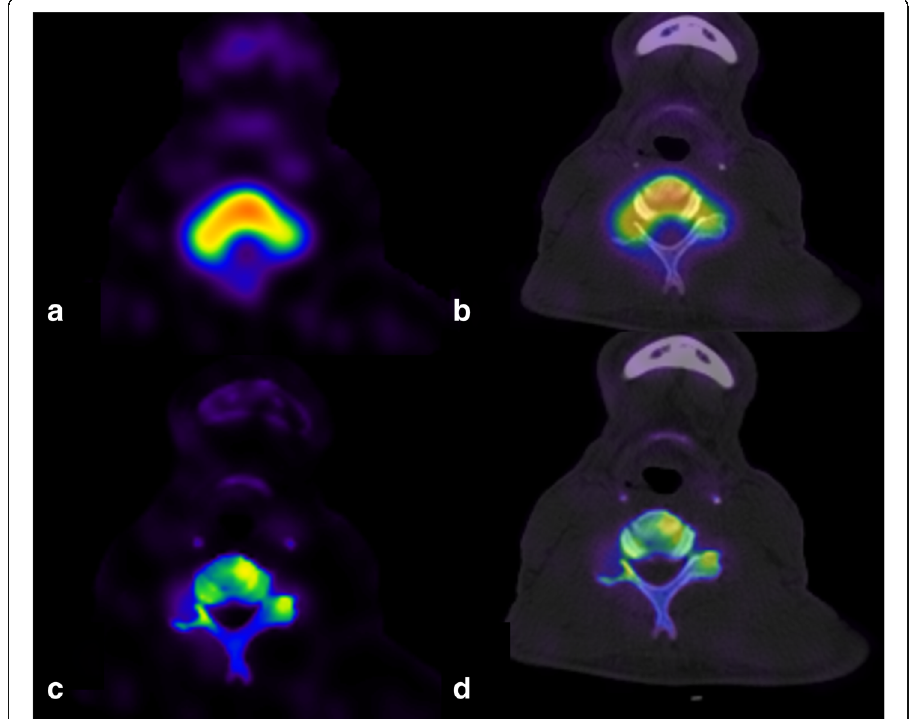
Fig. 4 Patient presented with neck pain for evaluation. Detailed Legend: Subsequent xSPECT and SPECT fusion at the C6 level are shown. a SPECT, b SPECT/CT, c xSPECT, and d xSPECT/CT. Final diagnosis was metastatic adenocarcinoma of the